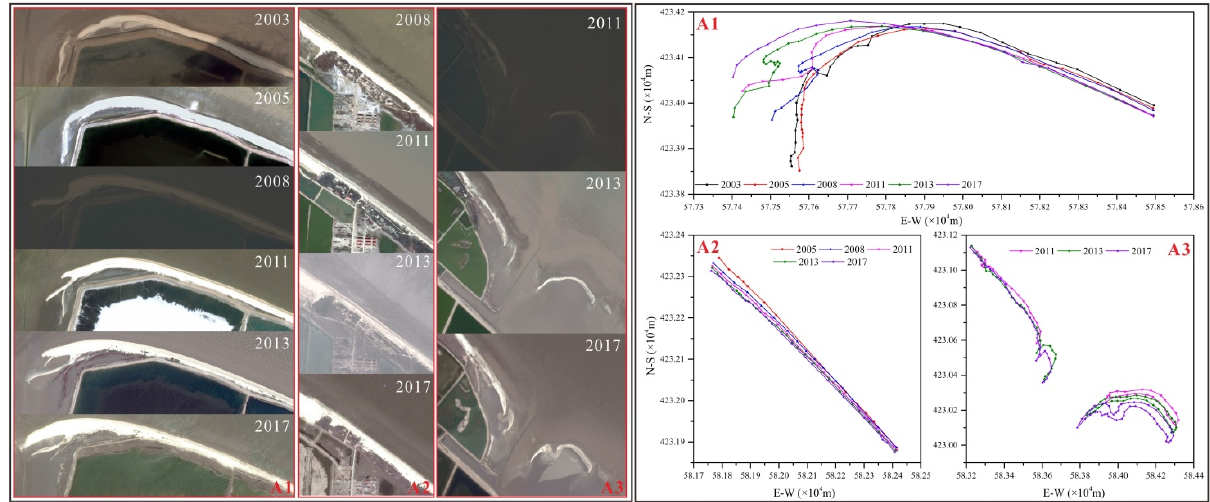
Figure 4. Left : Remote sensing images of the shelly chenier, right : change in the seashell beach edge recognized from a remote sensing image; A1 and A3 are tidal channel shelly cheniers and A2 is an open shelly chenier.